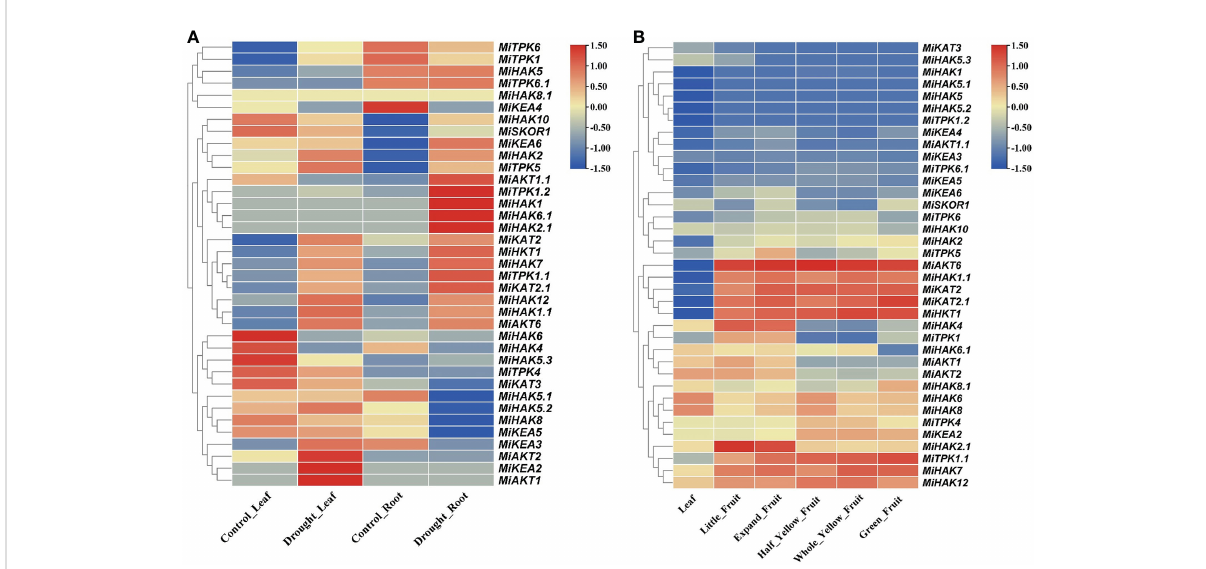
FIGURE 5 (A) Pro fi les of PTG expression in leaves and roots of Mangifera indica . The expression values [log2(FPKM)] are shown by the colored bar. Red denotes high expression, yellow denotes no expression, and blue represents low expression. (B) Pro fi les of PTG expression during fruit development. The expression values [log2(FPKM)] are shown by the colored bar. Red denotes high expression, whereas blue denotes low